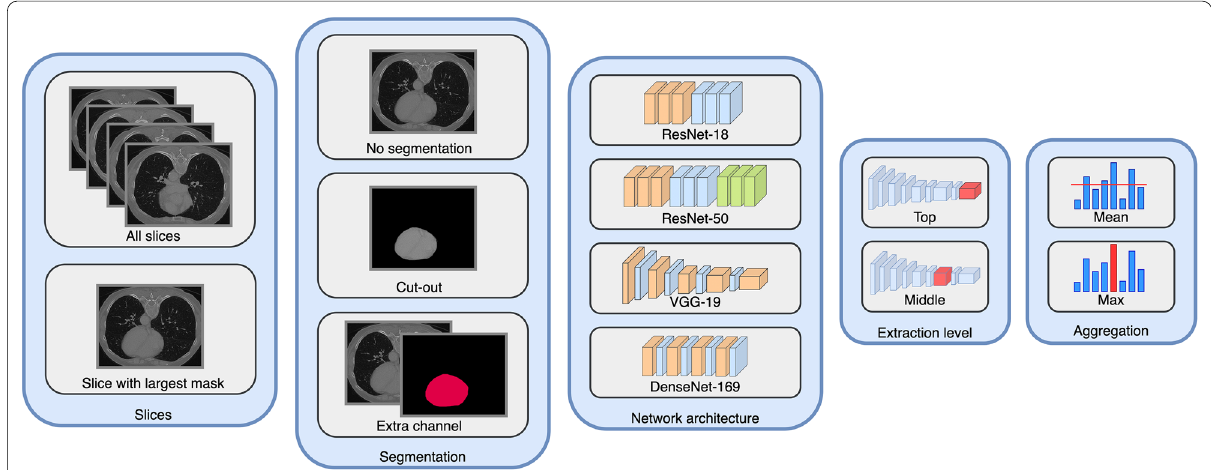
Fig. 3 Graphical display of the choices for the extraction of deep features